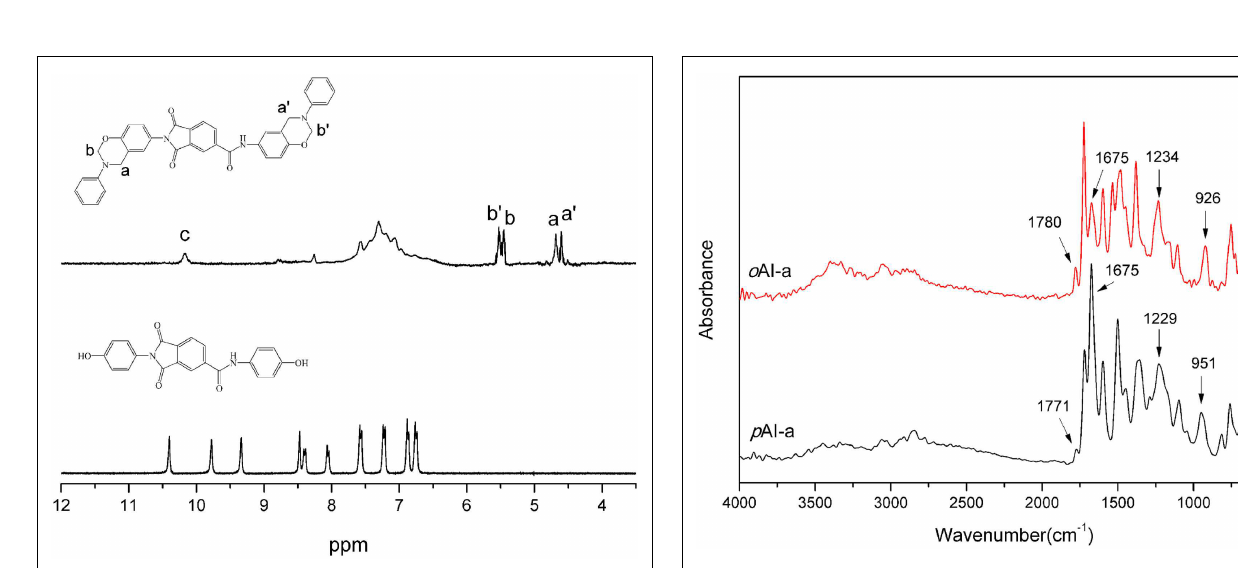
FIGURE 1 | 1 H NMR spectra of p AI and p AI-a .